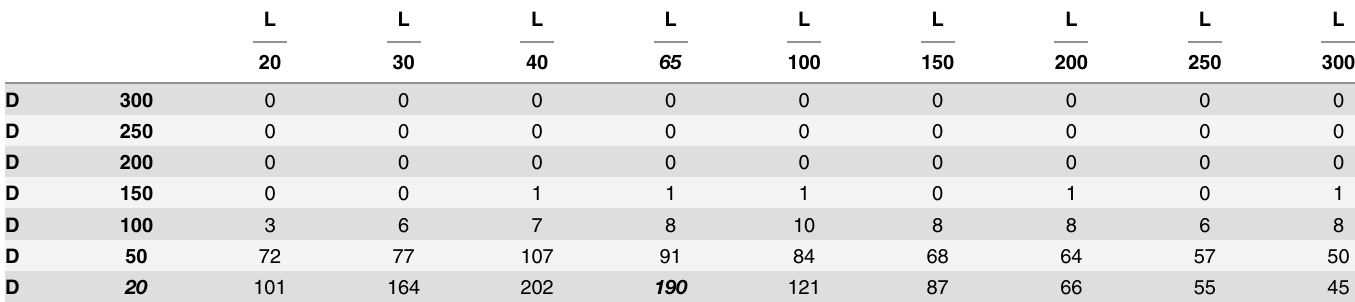
Table 3. Simulation results for a 5,000-ms period at 5,000 photons/s and a threshold of 6. The average values over 6 trials are given. L indicates L window , D indicates D window